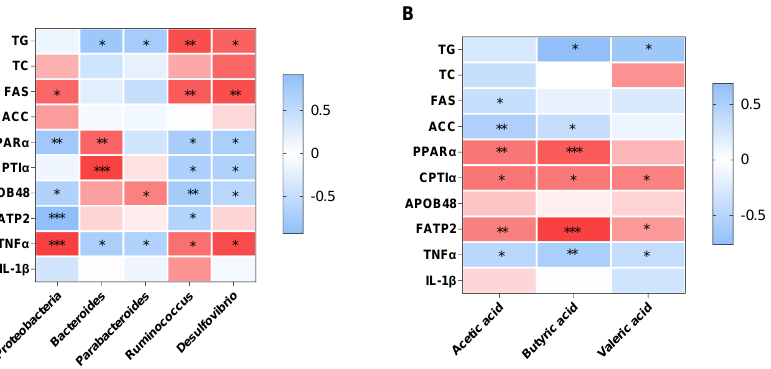
Figure 5. Heatmap of the correlation analysis of the altered gut microbiota ( A ) and SCFAs levels ( B ) with the NAFLD-related parameters in offspring mice. * p < 0.05, ** p < 0.01 and *** p < 0.001 represent a significant correlation. Abbreviation: TG, triglyceride; TC, total cholesterol.